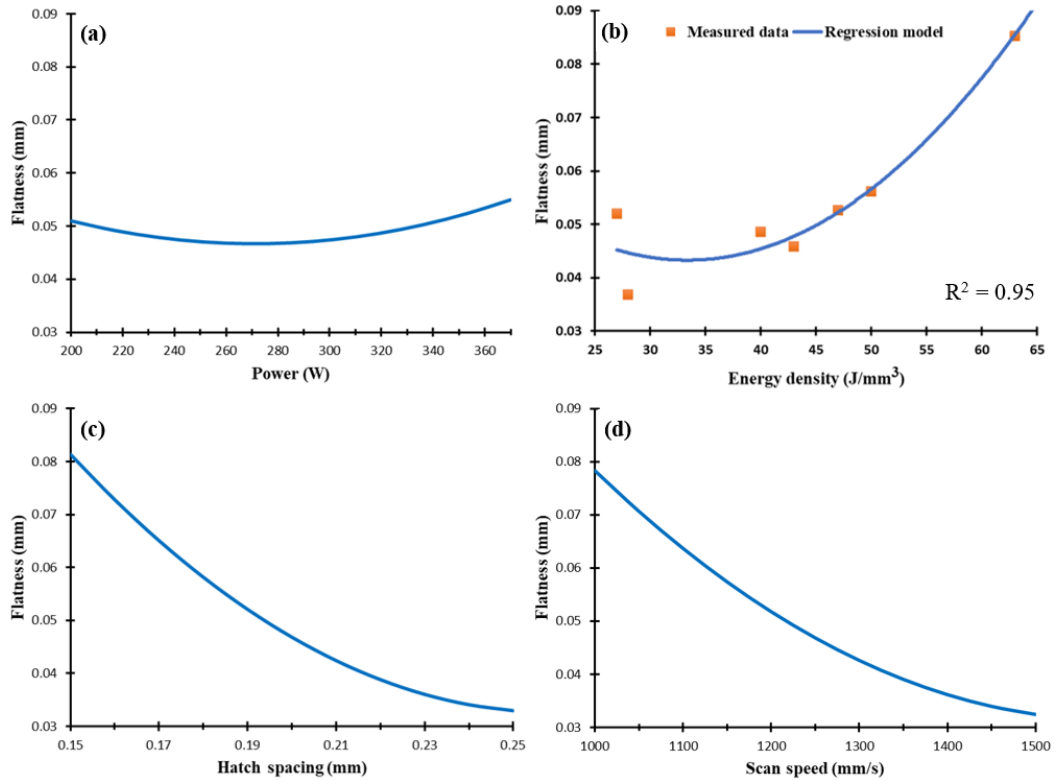
Figure 15. Surface flatness of the as-built AlSi10Mg samples vs. ( a ) laser power (W), ( b ) energy density (J/mm 3 ), ( c ) hatch spacing (mm), and ( d ) scan speed